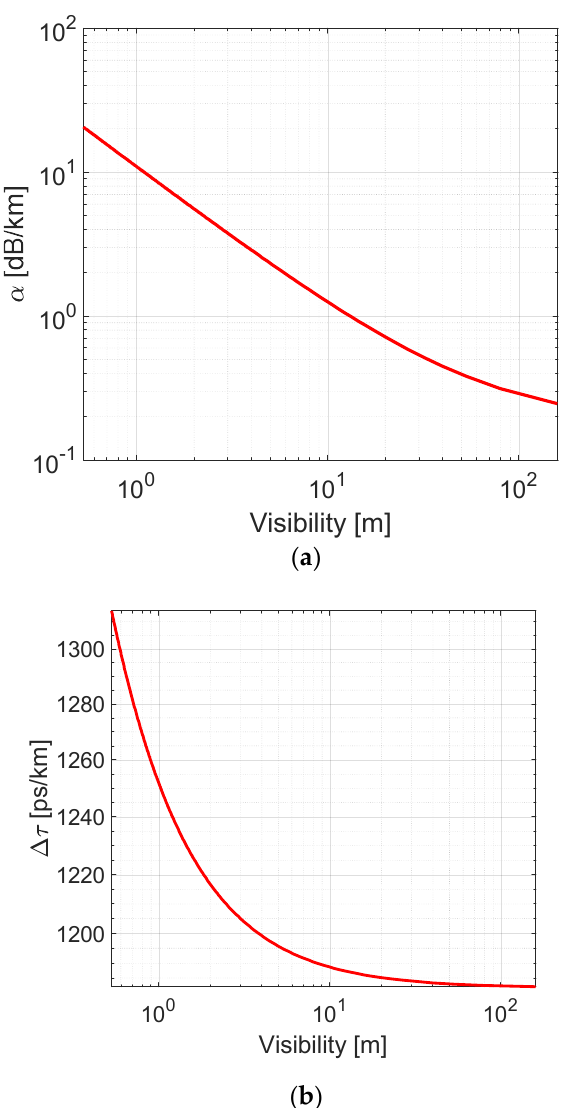
Figure 15. ( a ) attenuation and ( b ) incremental group delay of 28 GHz mmW for different fog visibility values.